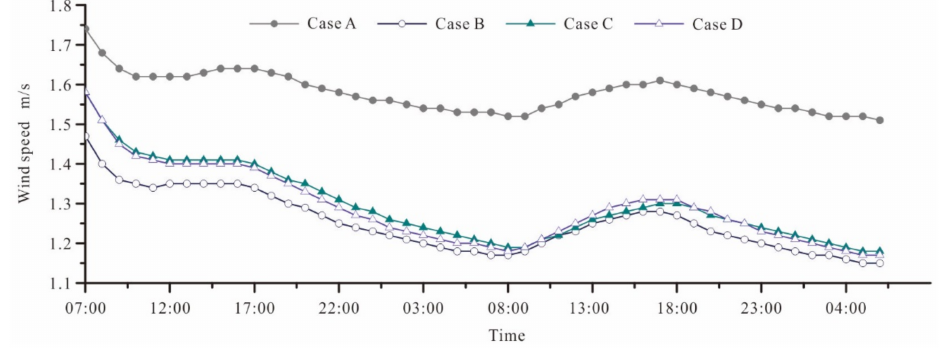
Figure 9. Temporal profile of wind speed at point P.